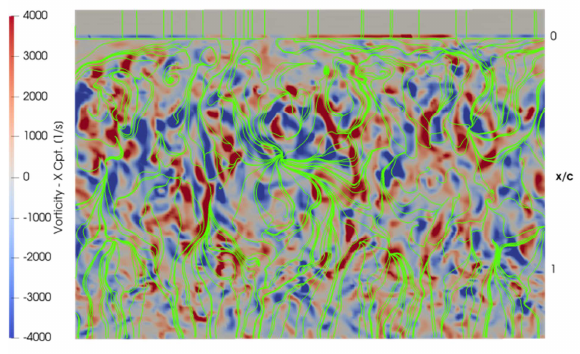
Fig. 5 . Plane y w /c = 0.01 m . Instantaneous spanwise vorticity contours and surface vector lines of instantaneous velocity.